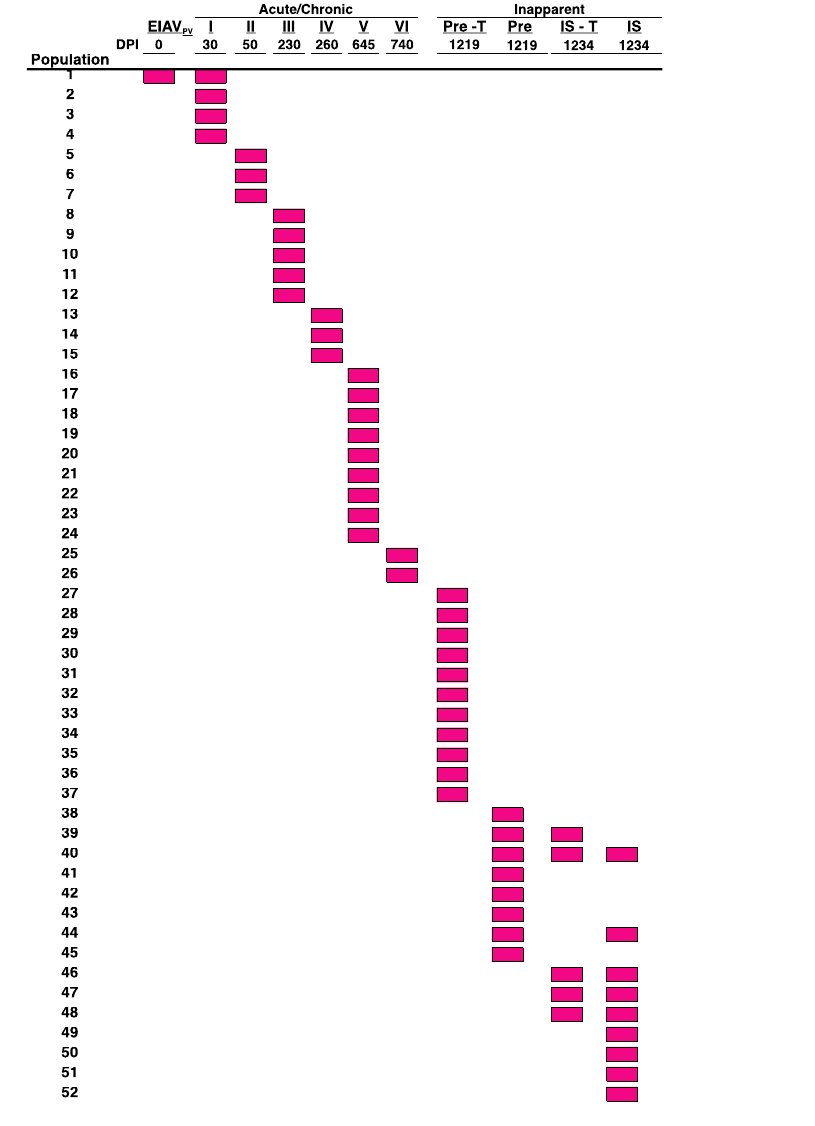
Figure 4. Temporal evolution of gp90 V3 envelope species demonstrates new species with each population. Temporal evolution of the gp90 Env V3 domain of longitudinal viral populations from an experimentally infected pony is represented graphically. Each distinct gp90 V3 region is depicted as a separate square, or population 1 through 52. Viral plasma species were determined for the acute and chronic stages from fever episodes I through VI, and from the inapparent stage prior to and during immune suppression in both plasma and tissues (lymph node, liver, and spleen). EIAV , lab strain inoculum; Pre-T, pre-immune PV suppression tissue; Pre, pre-immune suppression plasma; IS-T, immune suppression tissue; IS, immune suppression plasma (Figure modified from original in Craigo et al .